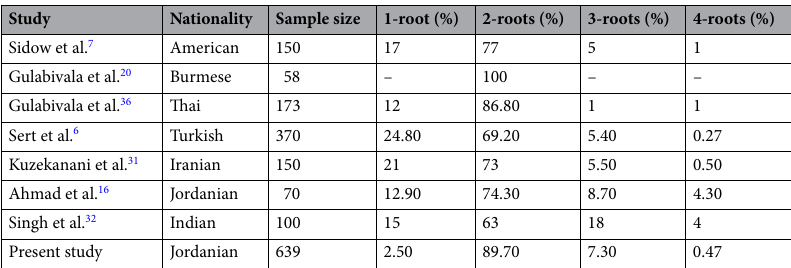
Table 6. Percentage of root number of mandibular third molars in previous studies and the present one.